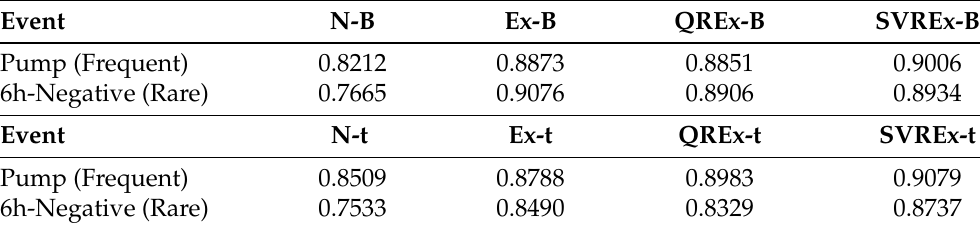
Table 6. Event-based Evaluation: AUROC.